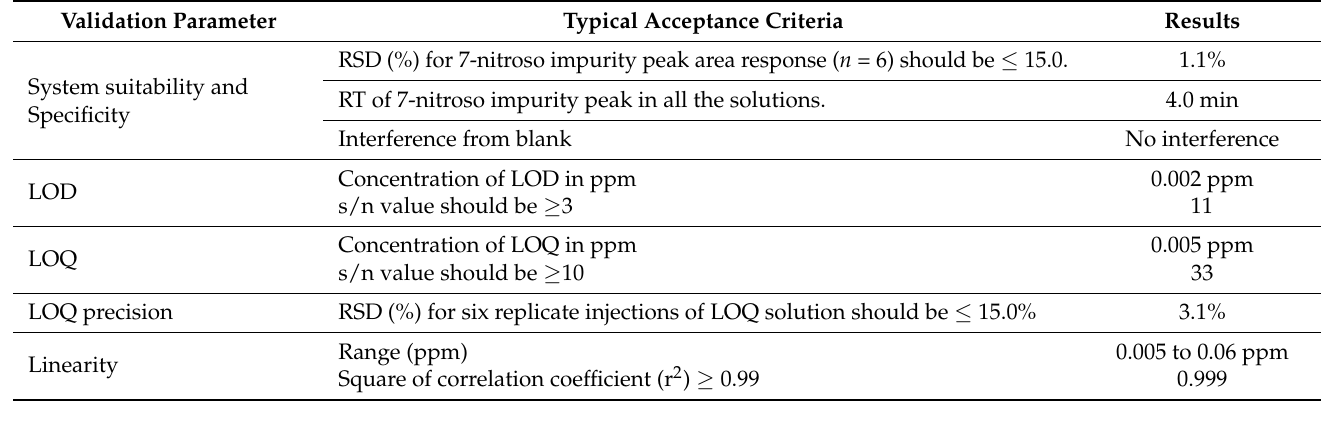
Table 2. Summary of results of the method validation.